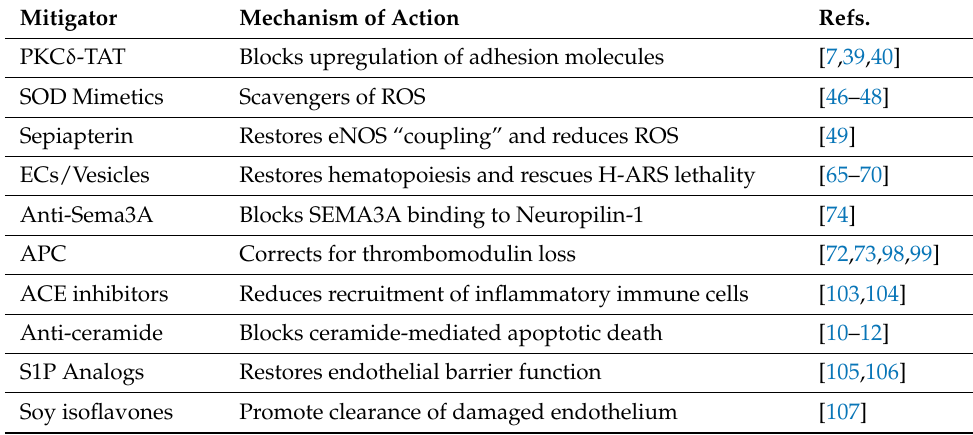
Table 1. Candidate Mitigators of Radiation-Induced Endothelial Cell